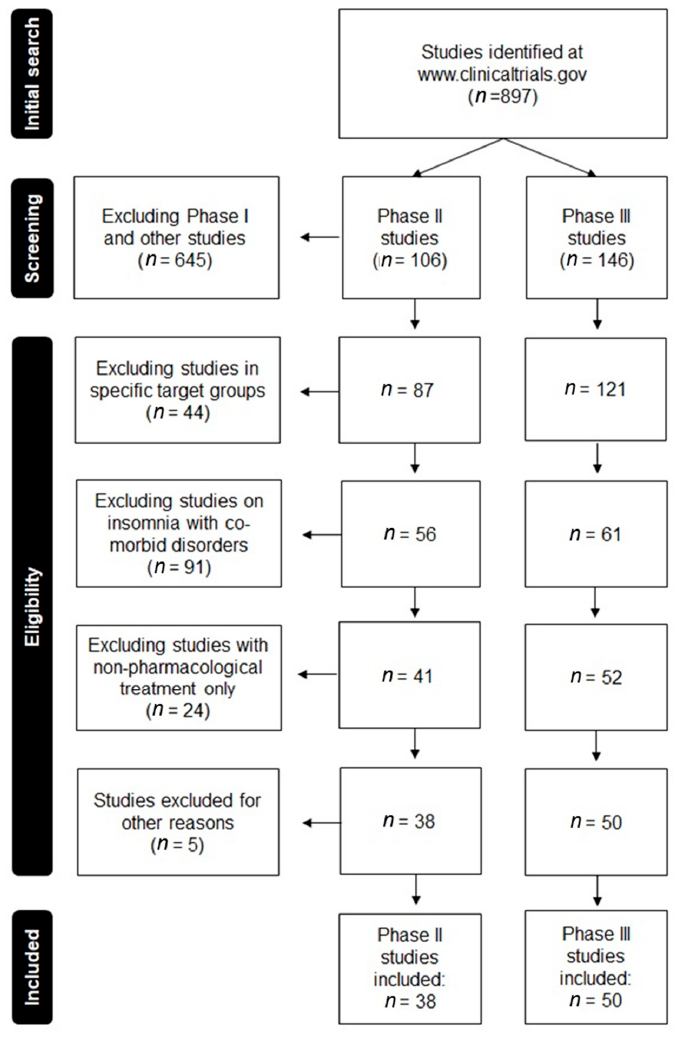
Figure 1. Flow chart summarizing the selection of relevant Phase II and III clinical trials in insomnia.